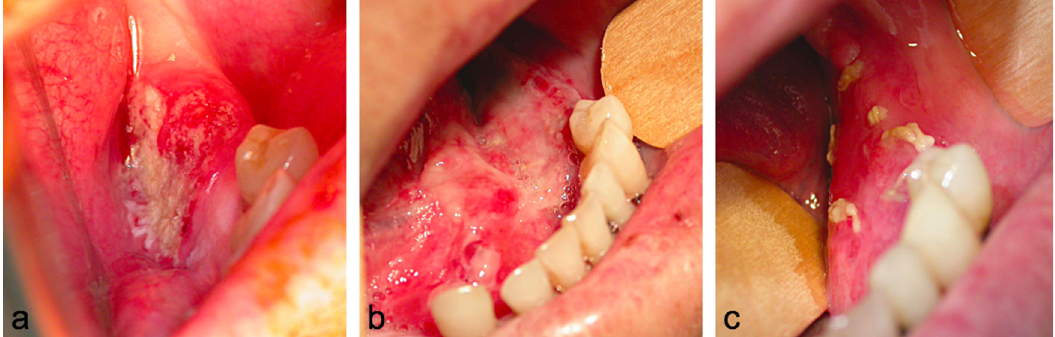
Fig. 3. Intrabuccal photograph of an oral lesionof the left gingival mucosa before removal andreconstruction (a). The same patient the next day after reconstruction with a sublingual gland (b), and 3 weeks after the procedure